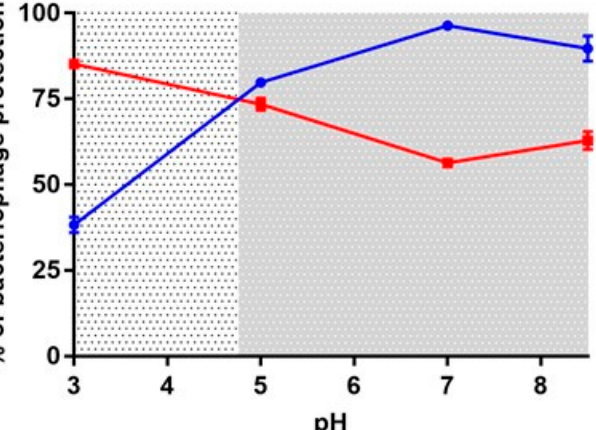
Figure 6. Phage recovery from exposure to pH mimicking in vivo conditions. The dotted shading (left) represents values where the beads would be expected to protect the phages and therefore high recovery indicates a high level of protection, while the grey shading (right) represents pHs where the ALG matrix would be expected to release phages, so a low recovery would indicate a high level of release. Phages were exposed to pH according to the transit time of the anatomical sections of the chicken GIT (proventriculus + gizzard at pH 3 for 45 min, duodenum at pH 5 for 15 min, jejunum + ileum at pH 7 for 30 min and cecum at pH 8.5 for 20 min).